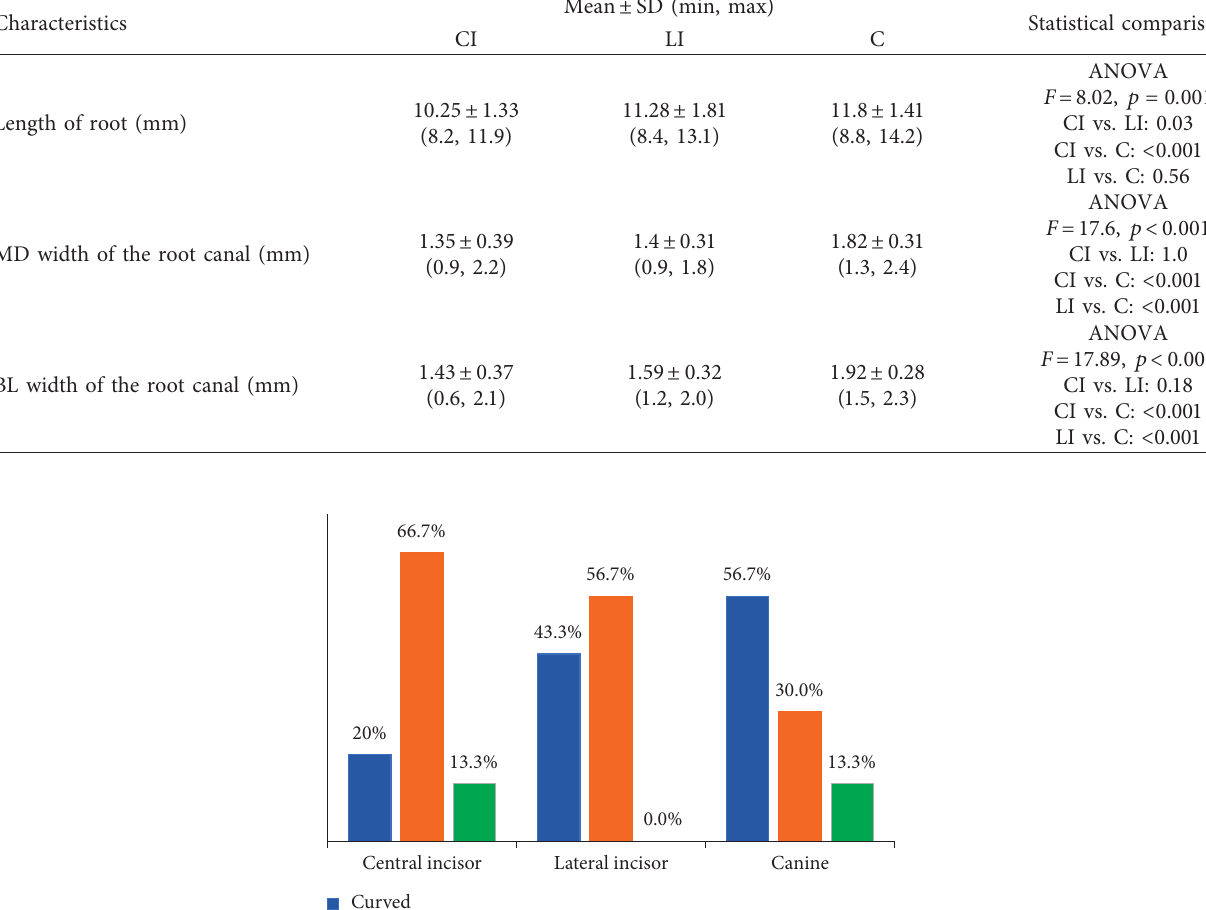
Table 2: Intergroup comparison of length of root, MD, and BL widths of root canals.